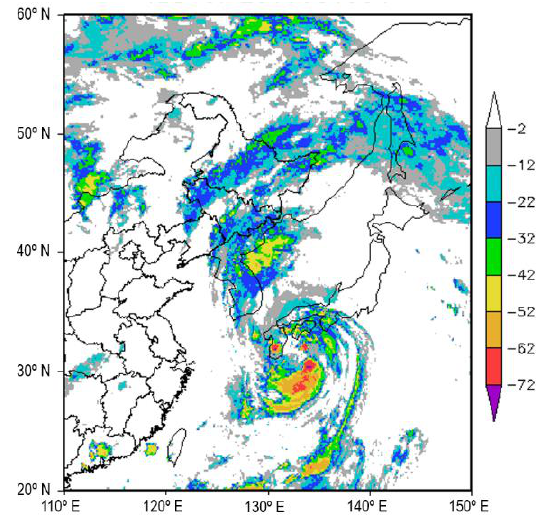
Figure 4. The HMW-8 satellite image (TBB, unit: °C) at 20 UTC on 14 August 2019. From 1512 on, at 500 hPa, the cold vortex in Lake Baikal continues to descend south- ward and the transverse trough turns vertical. The 5640 gpm cold vortex was split into two parts and moved southward. The south one fell to the place of Hebei Province and the west part of Liaoning Province, meanwhile, the north one reached the junction of Mongolia and Inner Mongolia, and the cold vortex in the Bering Sea was stable, while the subtropical high weakened and retreated eastward, with a body decrease. Meanwhile, the contour line of 5800 gpm shrinks to the island of Japan, the northeast of China and the sea of Japan is a huge warm ridge. At 850 hPa, typhoon 1910 moved northward and entered the sea of Japan, guided by the residual vortex of typhoon 1909, its inverted trough moving through the border of Liaoning and Jilin Provinces, and entering into the central part of Heilongjiang and Jilin Provinces. At 1600, at 850 hPa, the residual vortex typhoon 1909 was located in Jilin Province, and due to the incorporation of typhoon 1910 circulation, the wind speed on both sides of the inverted trough of the residual vortex is strengthened, Nenjiang, Qiqihar, Harbin, and Changchun are at the west of the inverted trough, while Yanji, Yichun, and Linjiang are at the East. The precipitation centers of 6 h appear in Suifenhe River (44.2 ◦ N, 131.1 ◦ E, Heilongjiang Province), 41 mm, Jixi (45.2 ◦ N, 130.6 ◦ E,